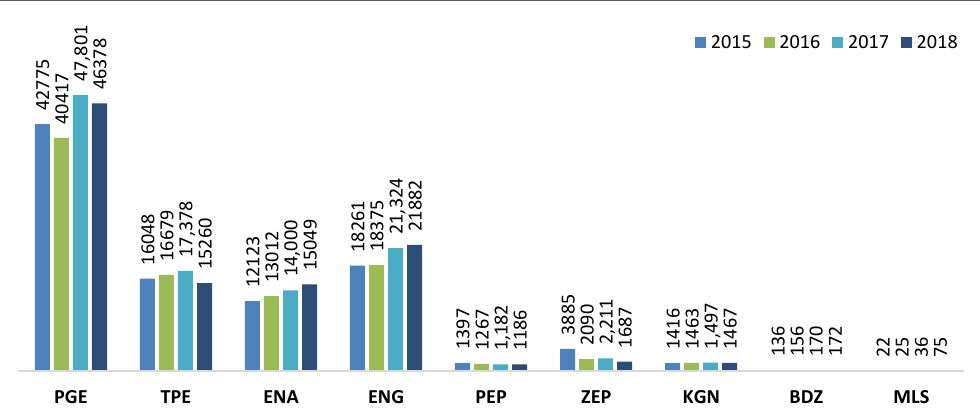
Figure 4. Sampled companies according to volume of equity capital (in mln of PLN).